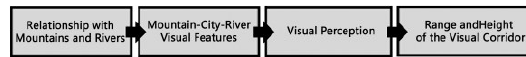
Viewing from the intersection of ③ From Shaolin Road Shaolin Road, Chengbei Road and viewing Wenling North road toward northeast, Qinyuan drawing tangent lines to the 300-meter Mountain contour line of Qinyuan Mountain. The range of the visual corridor is set by the projection of the four 3D lines onto the plane. (about 1/3 of the mountain body is in sight) Viewing from Nantai Rock in ④ From Nantai Rock in Qinyuan Mountain towards the Qinyuan historic city, making tangent lines Mountain cutting the outer boundary of East viewing West lake, and the shoreline of Jinjiang Jinjiang river. The range of the visual River corridor is set by the projection of the two tangent lines and the shoreline of Jinjiang river onto the